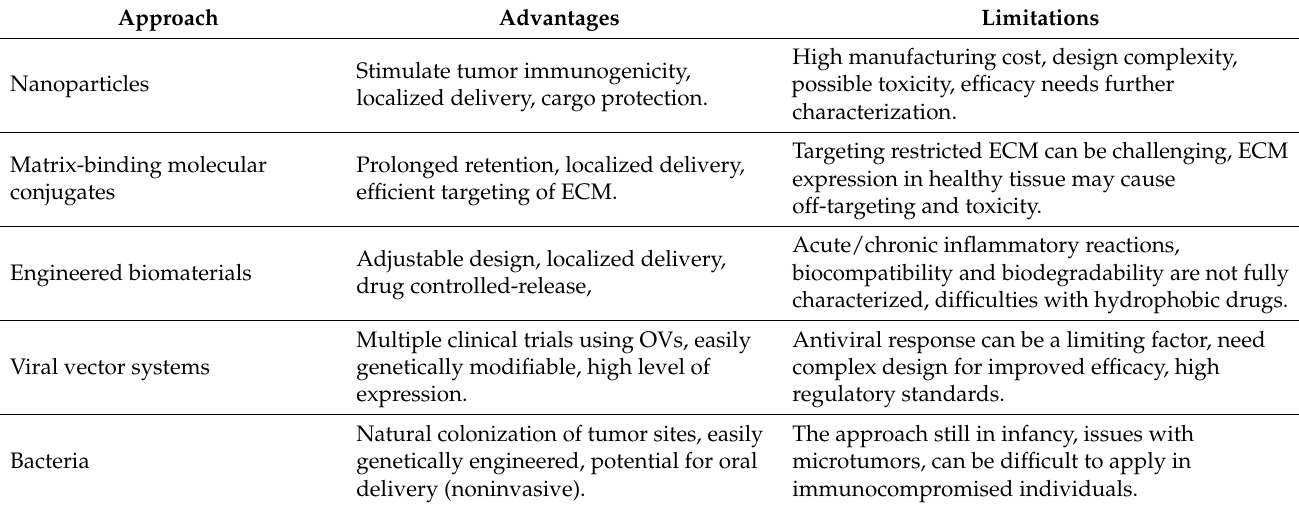
Table 5. Summary of selected novel delivery strategies for immune